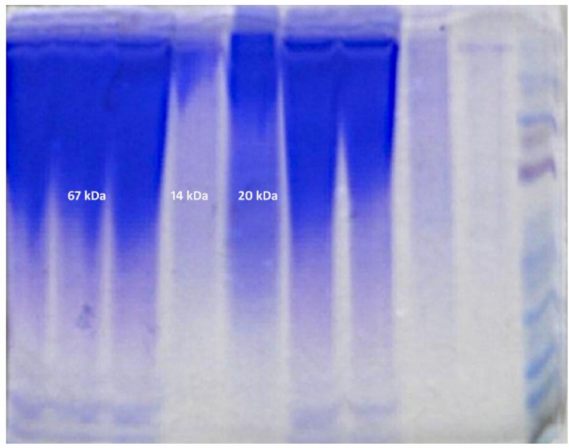
Figure 11. Electropherogram of the investigated protein samples in the spring-summer